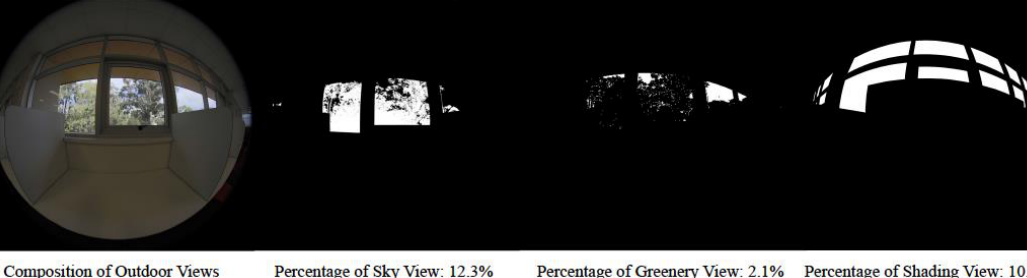
Figure 5. Example of the view analysis using the Sky View Factor Calculator.